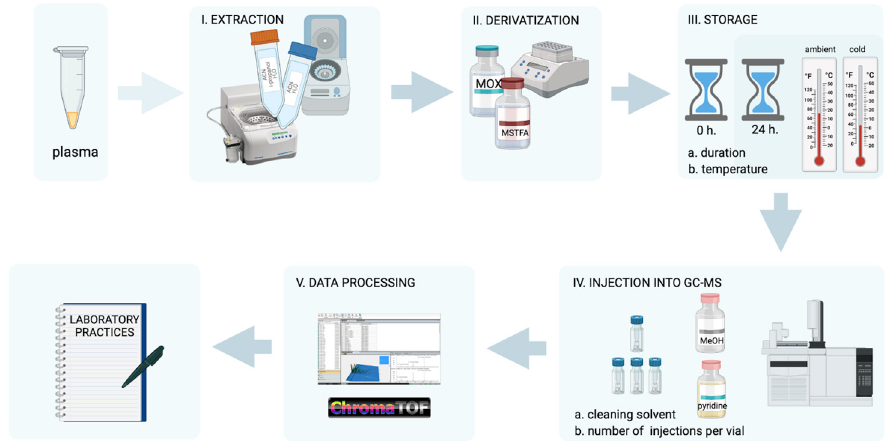
Figure 1. Scheme of the experiment. Blood plasma samples were uniformly prepared: we extracted low molecular weight compounds, then dried ( I ), methoxylated, and derivatized ( II ) the extracts. Our experiment implied three options for sample storage conditions before injection into the GCxGC-MS system ( III ): immediate loading or storage for 24 h (at ambient temperature and in a refrigerator at +4 °C). We washed the injection system with pyridine or methanol to evaluate the effect of the solvent used for syringe wash on the final signal on the chromatogram ( IV ) between injections. At the same stage ( IV ), we tested two schemes of sample loading into the chromatograph: we injected the sample from the same vial three times or used three intact vials. The resulting GCxGC-MS data were processed in a unified manner using the LECO ChromaTOF ( V ) software (v. 5.51) and statistically processed to develop final recommendations for sample storage and injection.